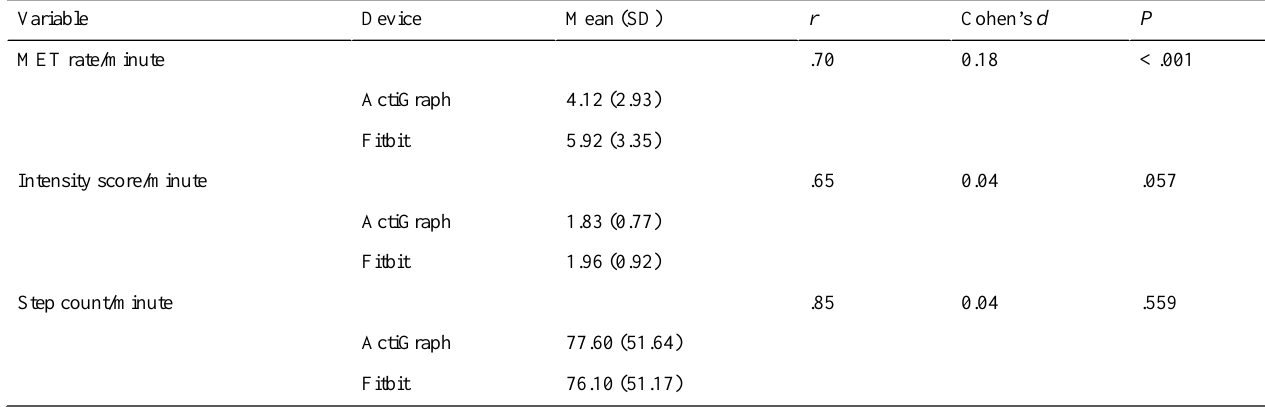
Table 3. Measurement differences for overall minutes of reported exercise bouts by device (N=120).